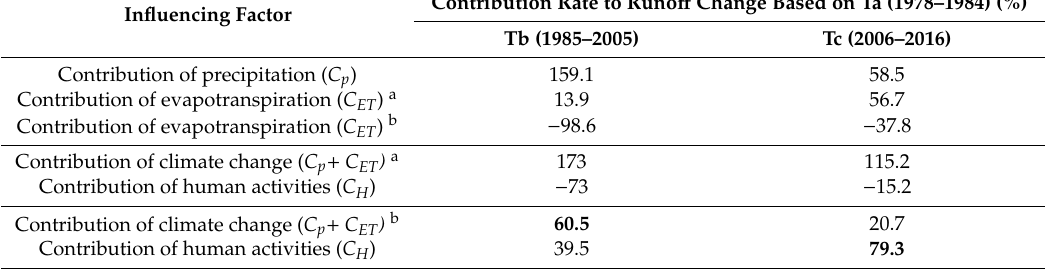
Table 5. Contributions rates of climate change and anthropogenic activities to runo ff variation by Slope Change Ratio of Accumulative Quantity (SCRAQ)